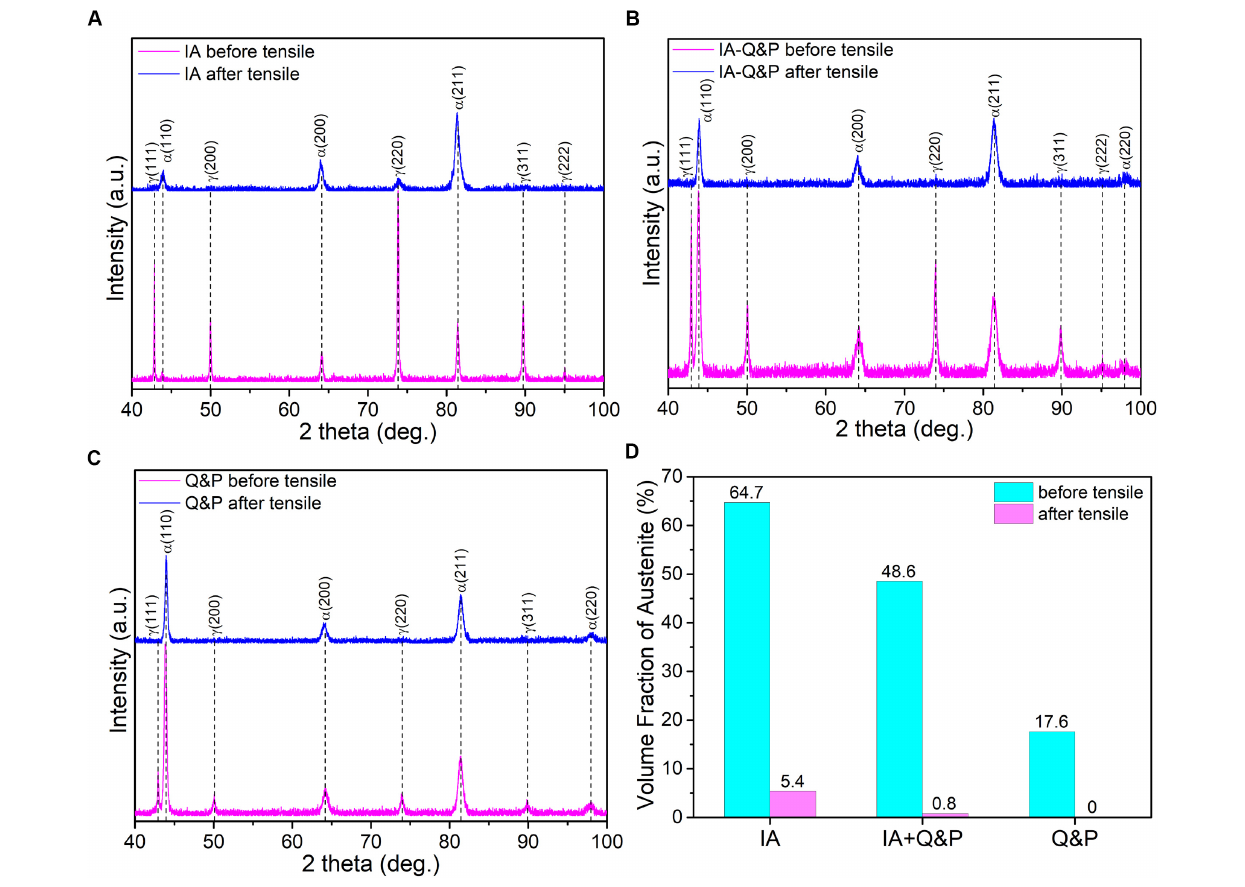
FIGURE 5 | XRD patterns of (A) IA (680 ◦ C/240 min), (B) IA-Q&P (800 ◦ C/10 min –350 ◦ C/10 min), and (C) Q&P (900 ◦ C/10 min –350 ◦ C/10 min) steels before and after tensile tests. (D) The volume fraction of austenite obtained from the XRD measurements. Note that austenite volume fraction in Q&P steel is negligible after tensile